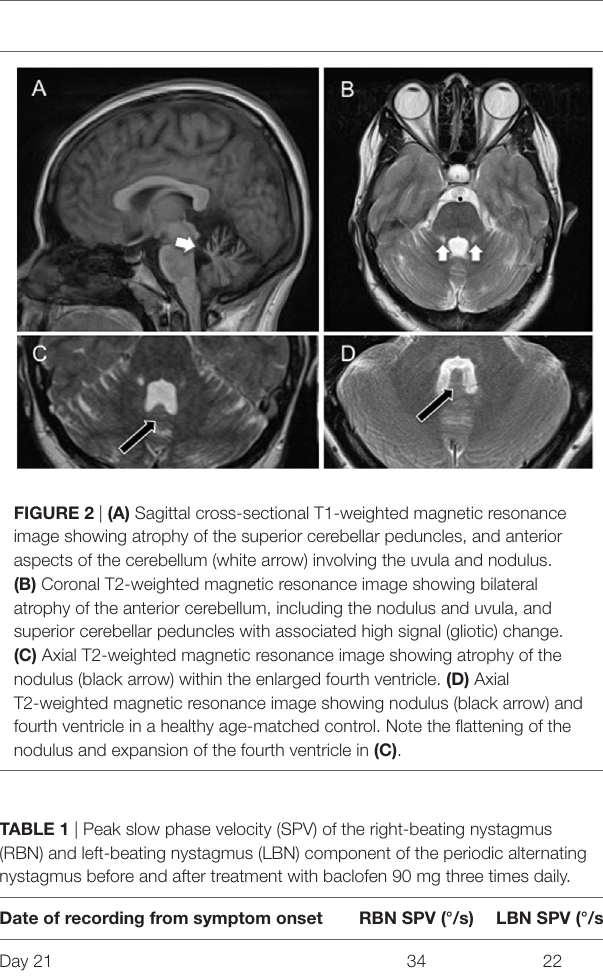
SPV was measured using videooculography, and with the patient looking in the primary position, in the dark.